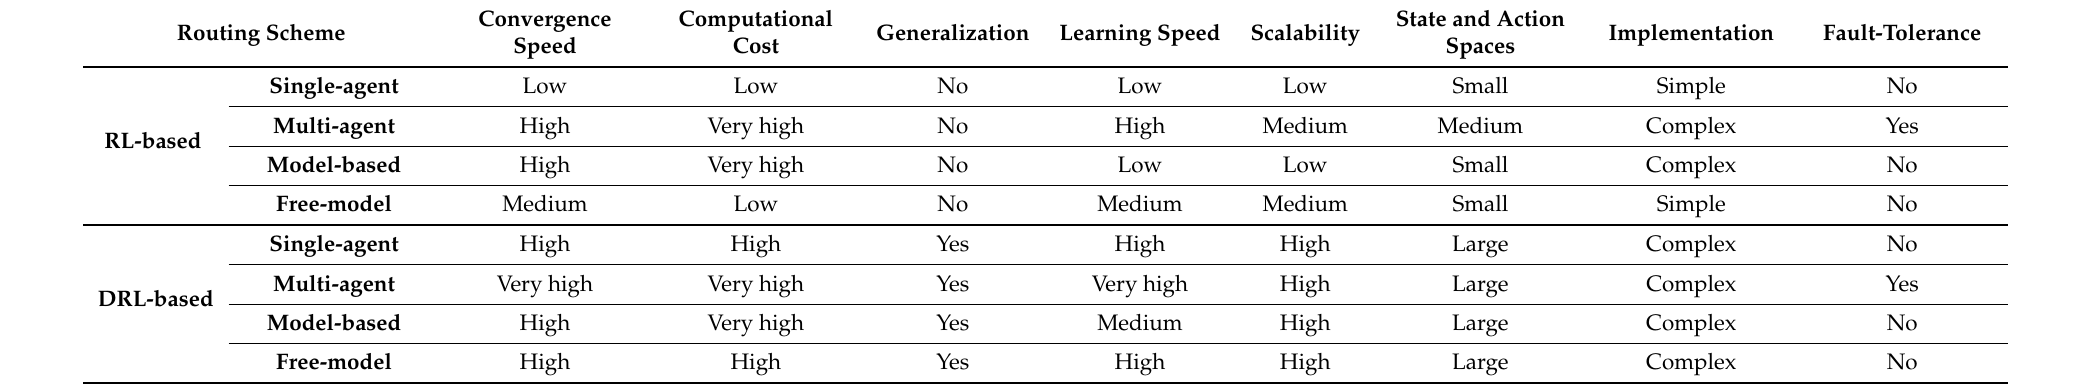
Table 2. Comparison of RL-routing methods and DRL-routing